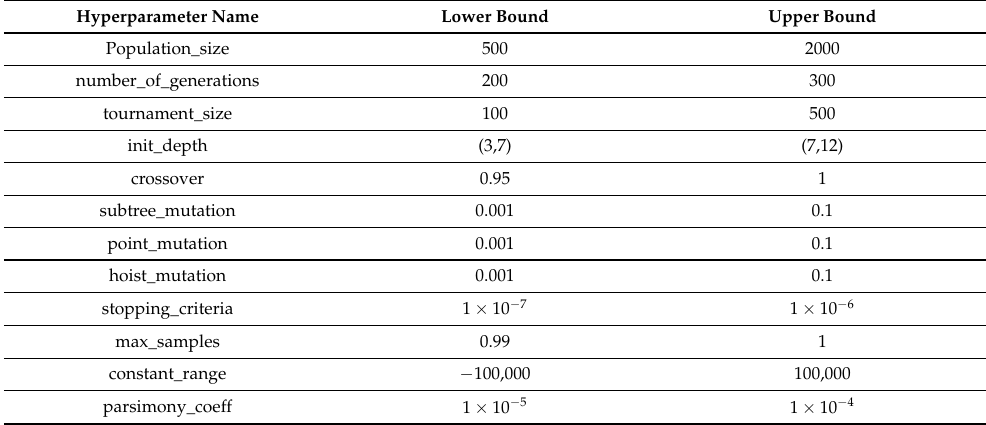
Table 5. The range of GPSC hyperparameters which were randomly selected in each execution of